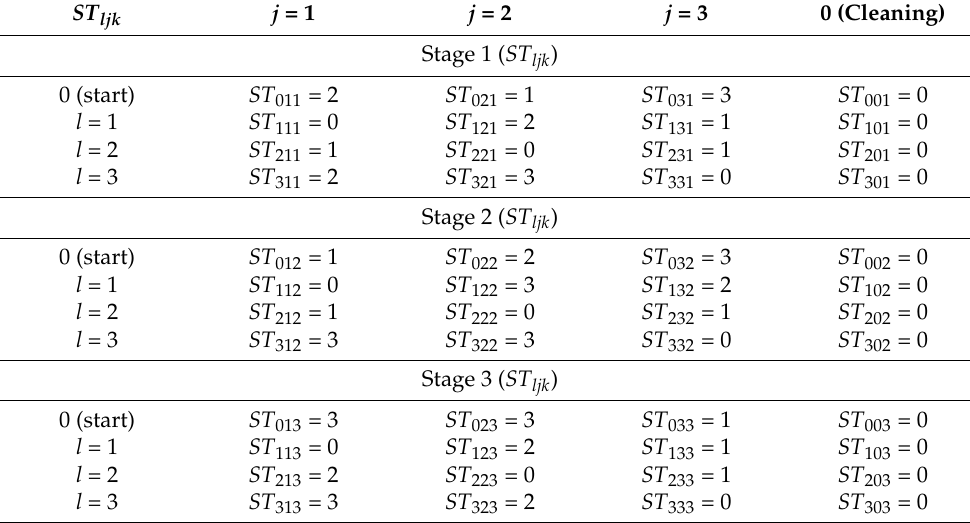
Table 1. Setup times for the RFFSP shown in Figure 1.